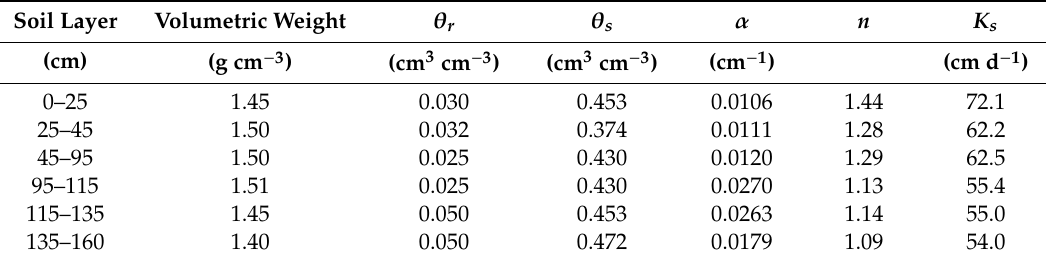
Table A1. Parameters for physical and hydraulic properties of soil profiles